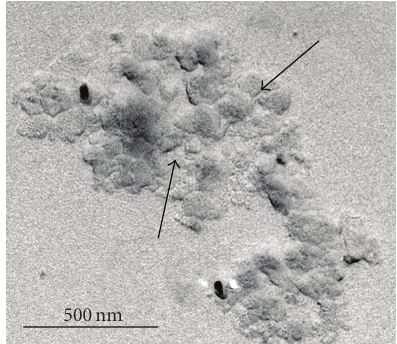
Figure 10: TEM image of guanosine derivative 2